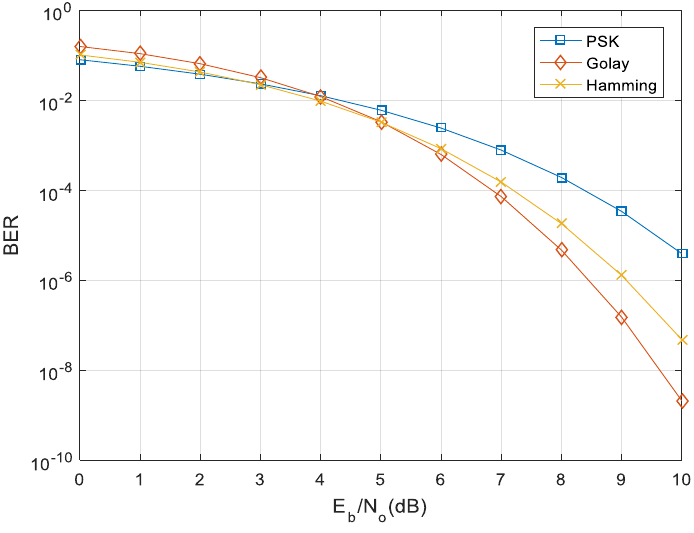
Figure 10. The BER (Bit Error Rate) under different PSK, Golay, Hamming.